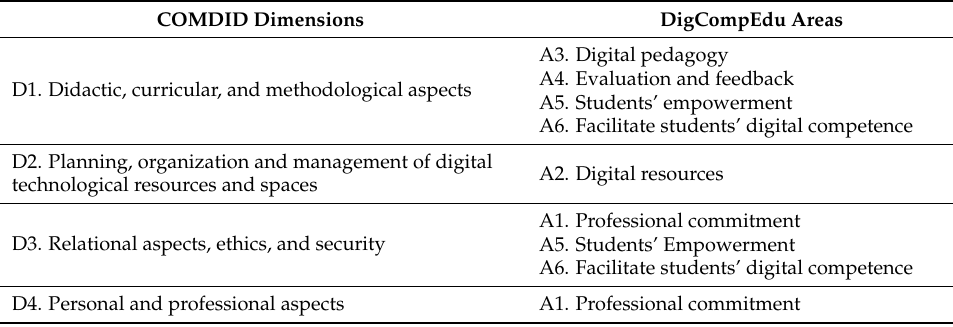
Table 10. Articulation of COMDID with DigCompEdu.